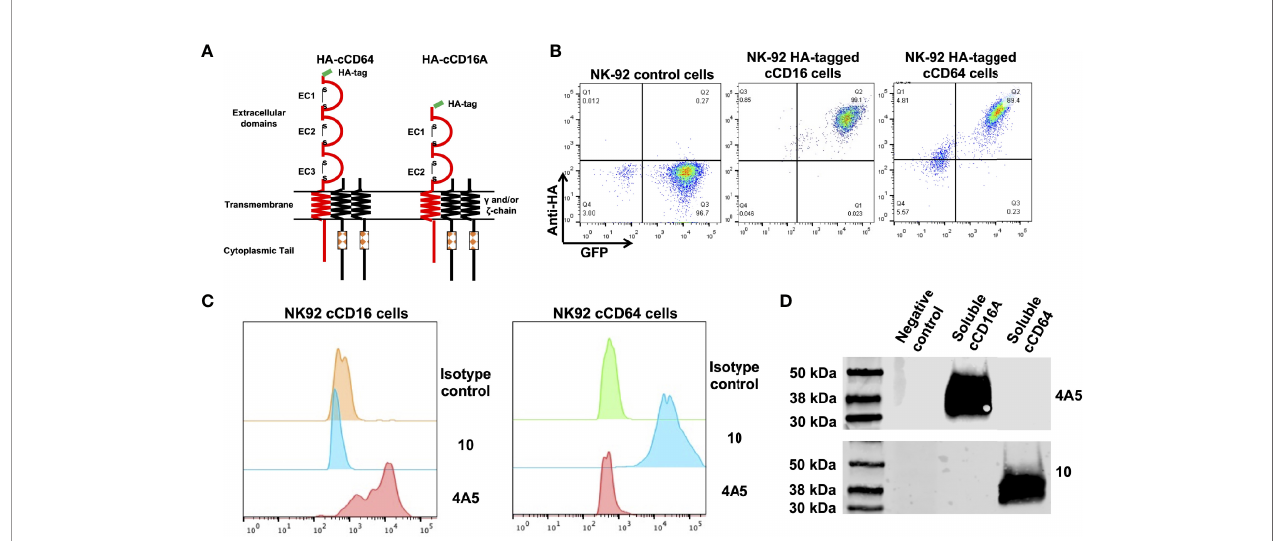
FIGURE 1 | Characterization of anti-canine CD16A and CD64 mAbs. (A) Schematic representation of recombinant intact canine CD16A and CD64 with an N- terminus HA-tag. The signaling adaptors FcR g and/or CD3 z ( g and/or z chain) non-covalently associate with human CD16A and CD64 as a homo or heterodimer. (B) Flow cytometric analyses of NK-92 cells transduced with an empty vector (control cells), NK-92 canine CD16A (cCD16A) cells, and NK-92 canine CD64 (cCD64) cells stained with an anti-HA mAb. (C) Flow cytometric analyses of NK-92 cCD16A cells and NK-92 cCD64 cells stained with an isotype-matched negative control mAb, the anti-canine CD16A mAb 4A5, or the anti-canine CD64 mAb 10. (D) Western blot analysis of recombinant soluble canine CD16A, recombinant soluble canine CD64, or soluble human CD177 (negative control) using the mAbs 4A5 or 10. Equal protein loading was con fi rmed by BCA. All data are representative of three independent